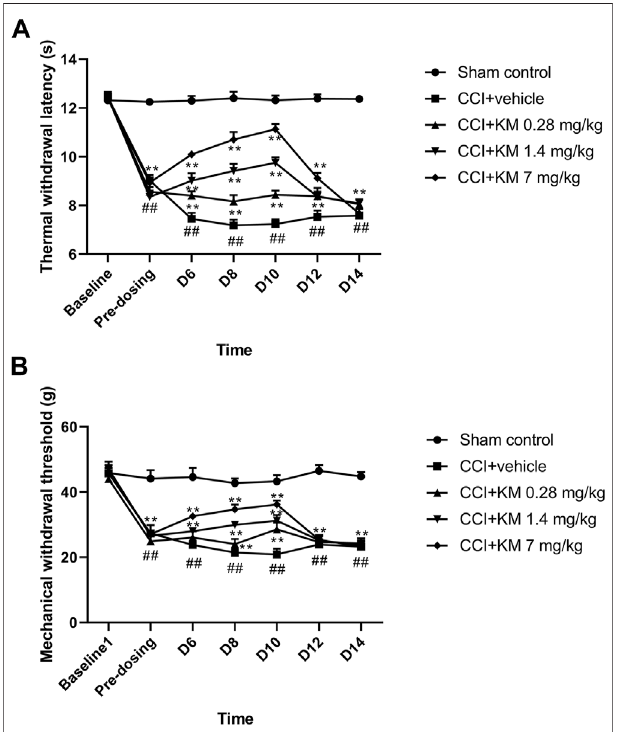
FIGURE 8 | The anti-NPP effect of koumine in sciatic nerve chronic constriction injury rats. (A) The time course of the effect of koumine on the thermalwithdrawallatency. (B) Thetimecourseoftheeffectofkoumineonthe mechanicalwithdrawalthreshold.Thedataarepresented asthemean ± SD (n (cid:2) 6) and were analyzed using two-way repeated analysis of variance (ANOVA)followedbyBonferroni ’ sposthoctest, ## p < 0.01comparedwiththe sham control group; ** p < 0.01 compared with the vehicle control group. KM, koumine.